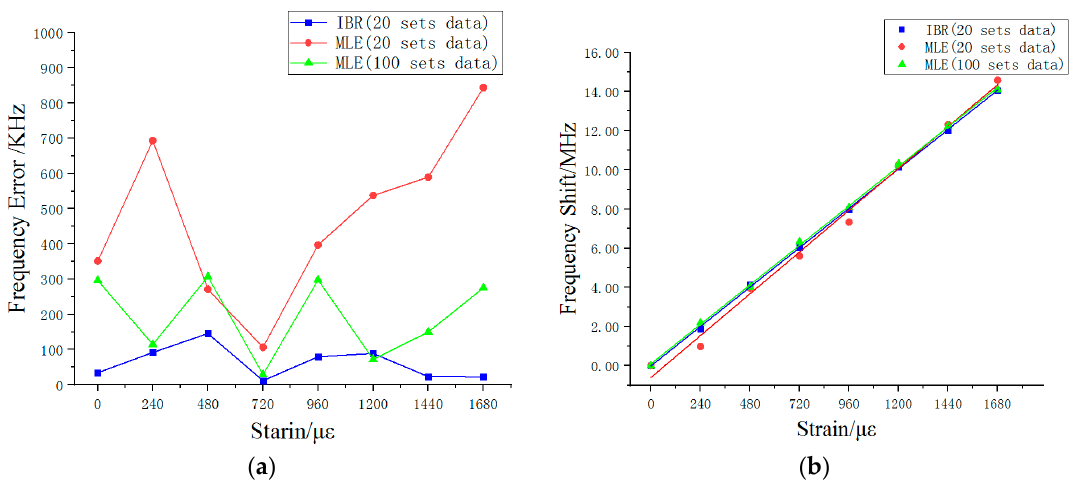
Figure 8. ( a ) The error rate of estimated results in each strain. ( b ) The estimated results and linear fitting by different sets of data.